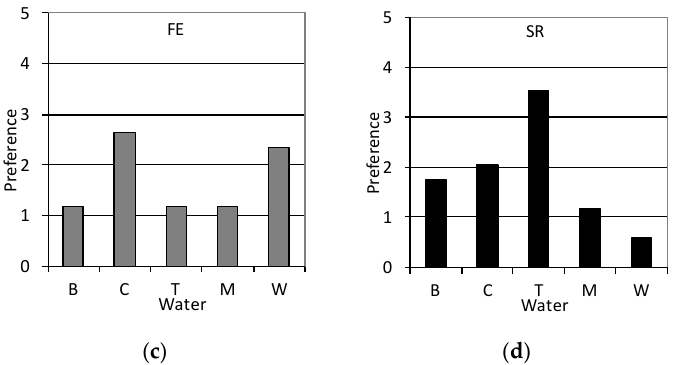
Figure 5. Preference of water by extract: ( a ) Bl, without extract; ( b ) TF, tocopherol; ( c ) FE, Fucus ; ( d ) SR, Sargassum muticum .